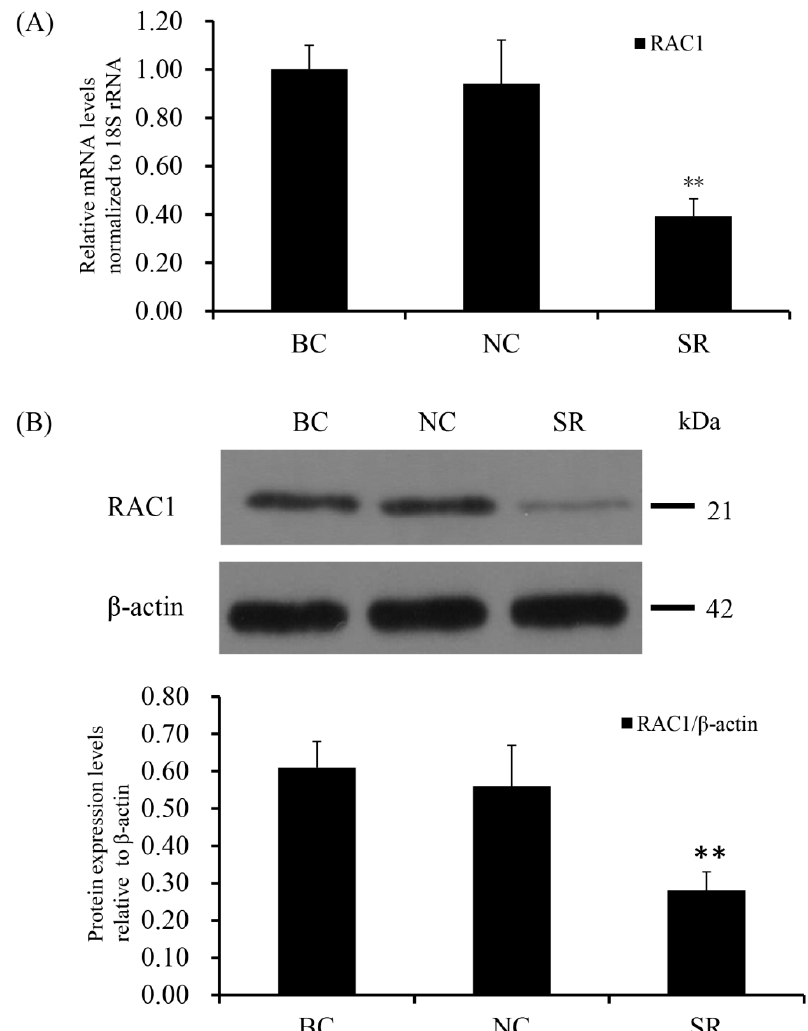
Figure 3. RAC1 mRNA and protein expression levels after cells transfected with RAC1 ‐ specific siRNA. D ifferent treatment groups were transfected into GCs from the prehierarchical follicles. SR group: exact siRNA RAC1 ; NC group: scrambled siRNA; BC group: absence of siRNA. ( A ) RAC1 mRNA expression was scrutinized by RT ‐ qPCR analysis with 18S rRNA as a normalization gene. ( B ) RAC1 protein expression was detected by western blotting analysis against β‐ actin protein. Data represent means ± SEM ( n = 10). Bars with superscripts suggest the statistically noteworthy difference in comparison to the control groups (** p ˂ 0.01).